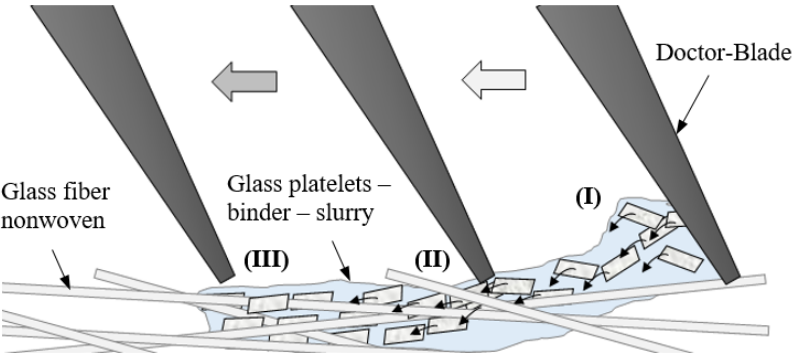
Figure 4. Illustration of the integration process of micrometer-sized glass platelets in a glass fiber nonwoven by tape casting.